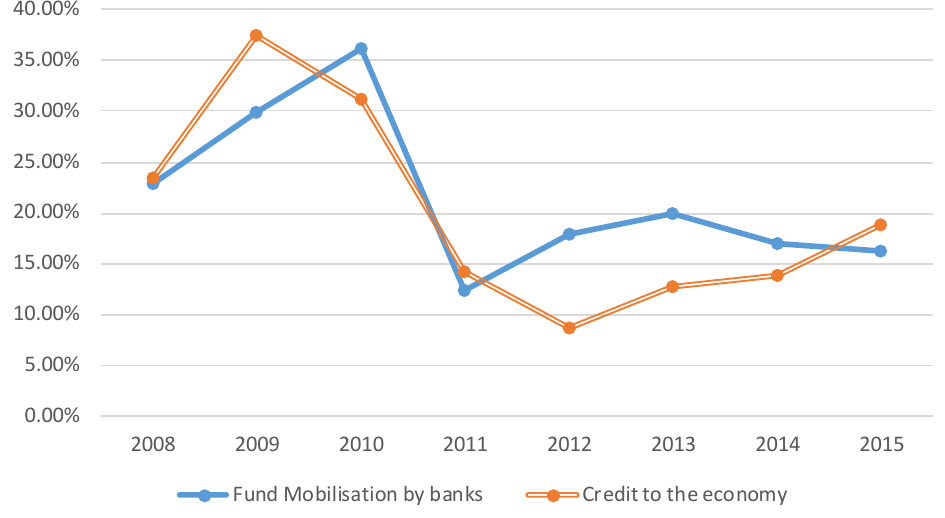
Figure 2. Fund mobilisation and utilisation of Vietnamese banks, 2008–2015. Source : SBV .